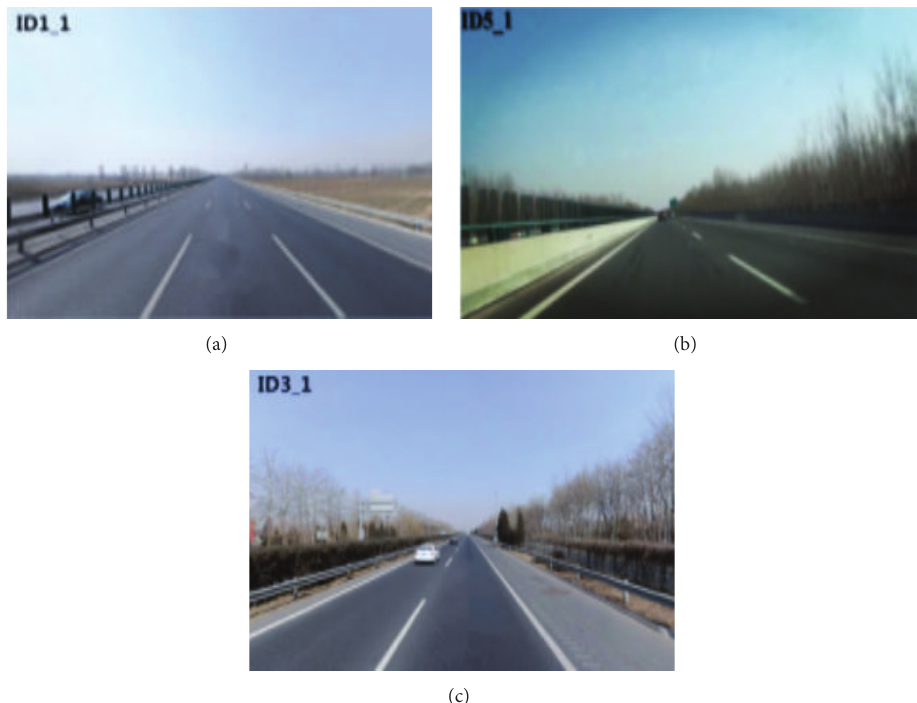
Figure 2: Typical landscape patterns in Daguang Highway. (a) Open. (b) Semiopen. (c) Vertical.